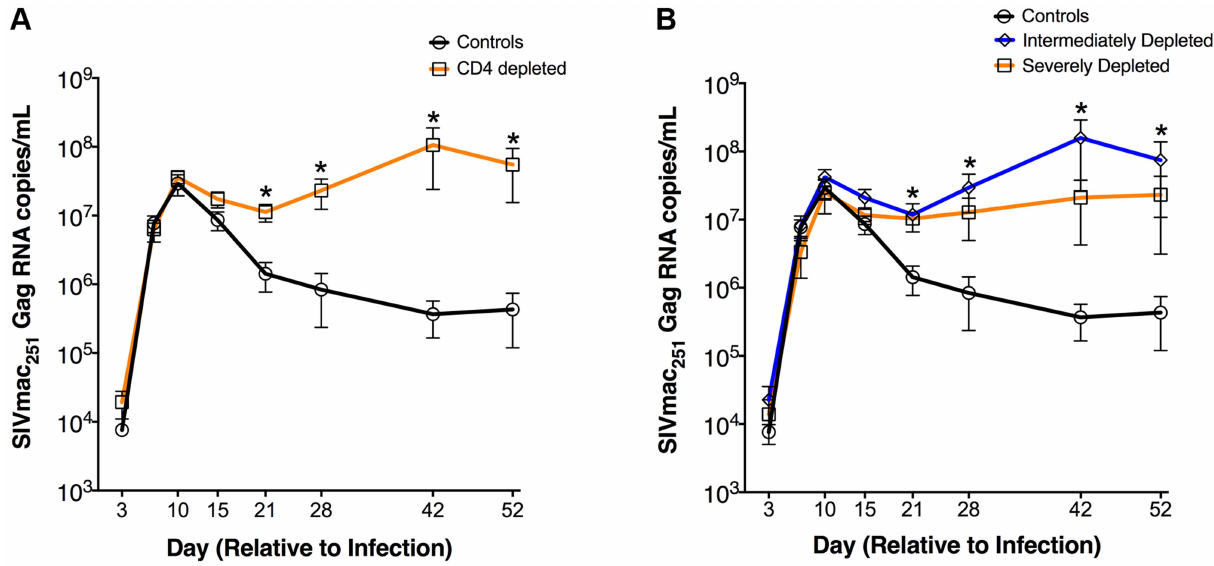
Figure 2. Increased plasma viremia in CD4-depleted SIV-infected RMs. Longitudinal levels (mean 6 S.E) of viral load, expressed as number of SIVmac251Gag RNA copies per mL of plasma, in CD4-depleted (orange square; n=8) vs. undepleted control (black circle; n=4) RMs ( a ) as well as in severely depleted (orange square; n=3), intermediately depleted (blue diamond; n=5) or undepleted control (black circle; n=4) RMs ( b ). In both severely- and intermediately-depleted RMs, viral loads were significantly higher than controls from day 21 to day 52 post-infection. *P ,